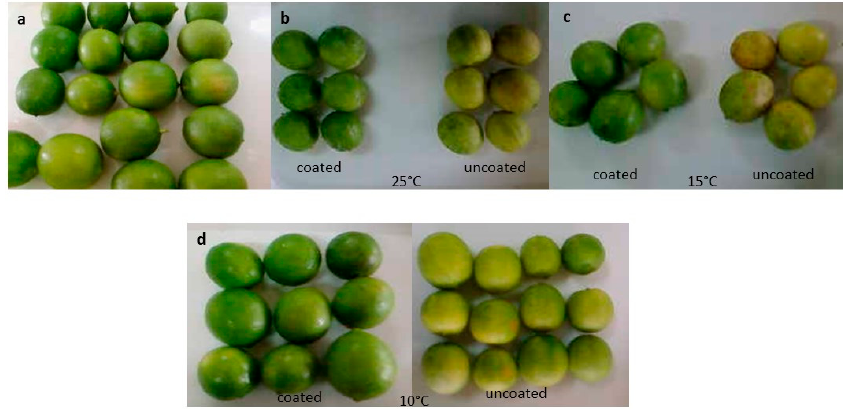
Figure 2. Photographs of lime samples: ( a ) day 1; ( b ) day 8; ( c ) day 25; and ( d ) day 32.